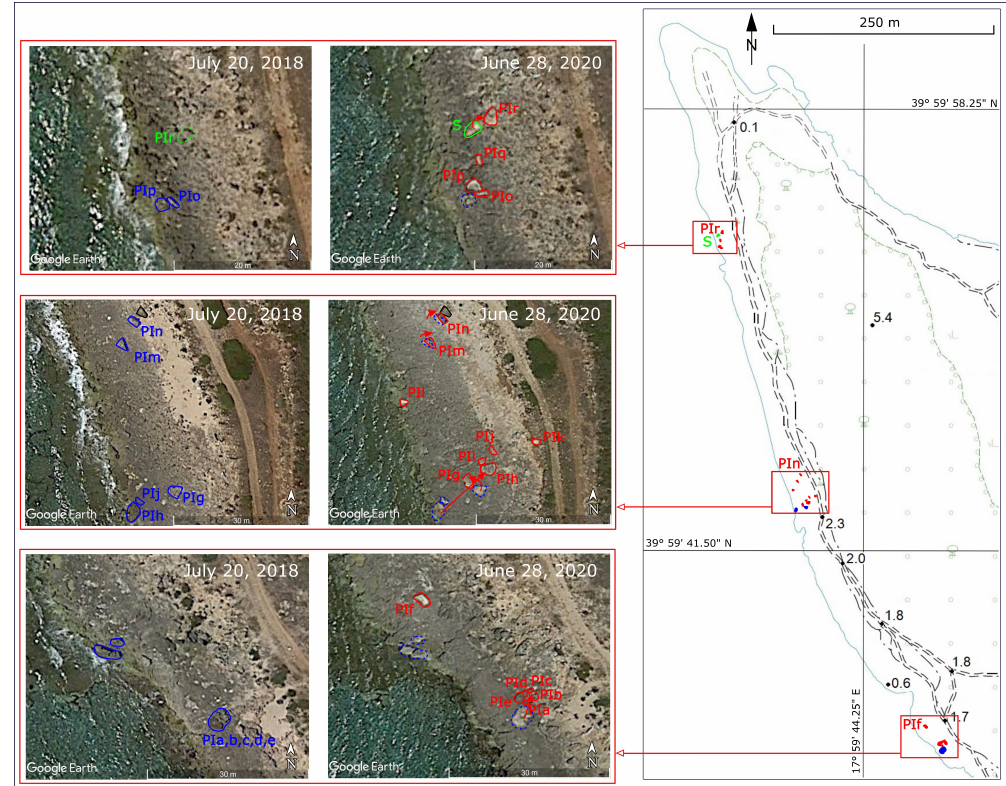
Figure 5. Comparative satellite images of Punta Pizzo. The initial positions of the boulders are highlighted in blue, the final ones in red, and the sockets are green. Red arrows highlight the displacements. Topography from the technical map of Lecce Province